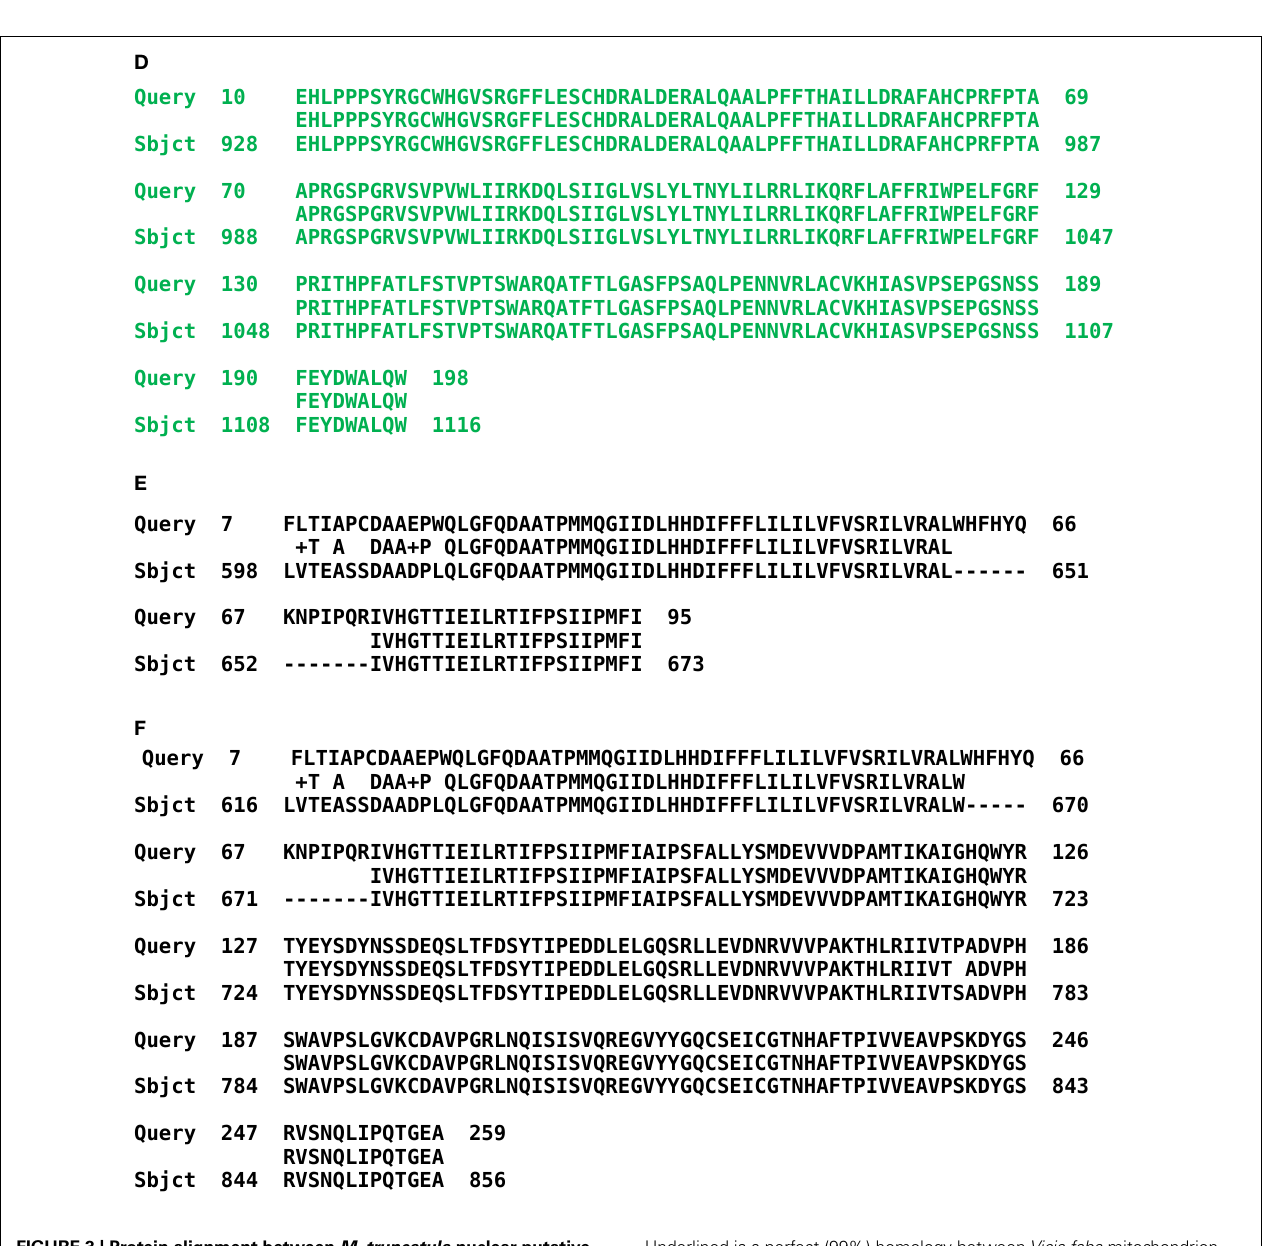
FIGURE 3 | Protein alignment between M. truncatula nuclear putative ORF1116 and ORF856 and Vicia faba mitochondrial genes atpA and cox2. (A) Amino acid sequence of M. truncatula chromosome 1 putative ORF1116 and (B) ORF856 (NCBI BLAST). Red colored is a homologous sequence between ORF1116 and ORF856. Black colored are different amino acids within area of homology between ORF1116 and ORF856 (red colored).